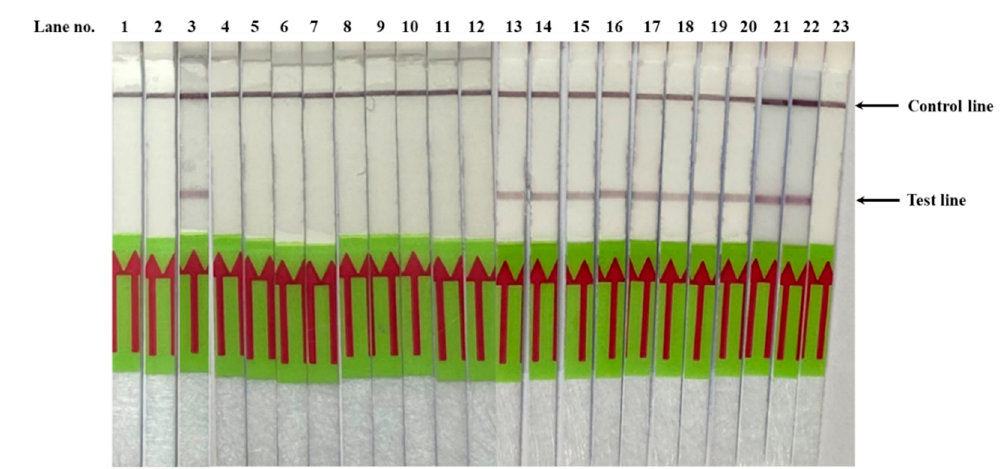
Figure 4. Validation of Pf SNP-LAMP-LFD assay performed on genomic DNA extracted from clinical samples of P. falciparum and P. vivax . Lane 1 was negative control (no DNA template). Lanes 2 and 23 were negative control samples (20 ng of pUC18- Pfdhfr -TM4 / 8.2). Lanes 3 and 22 were positive control samples (20 ng of pUC18- Pfdhfr -V1 / S). Lanes 4–12 were genomic DNA